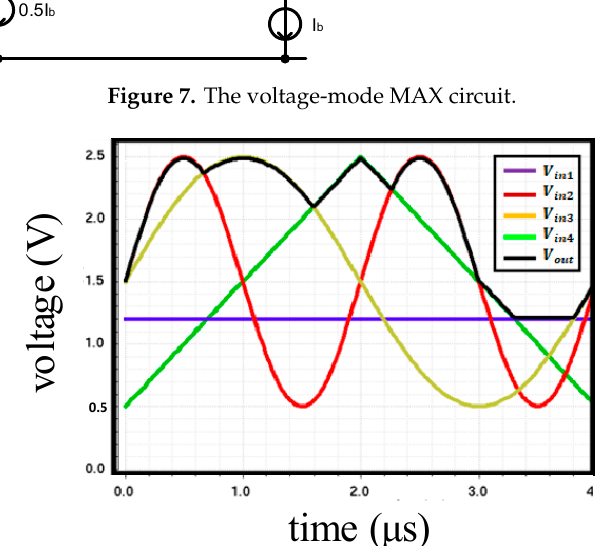
Figure 8. Simulation results of the voltage-mode MAX circuit.